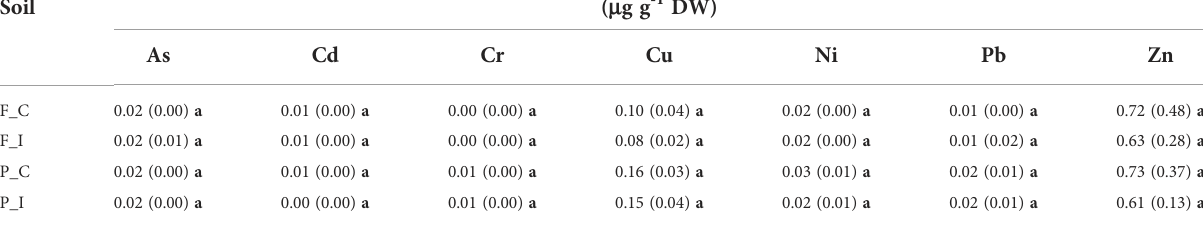
TABLE 1 CaCl 2 -extractable TE concentrations of topsoil samples (0-20 cm) from the two sites (mg kg -1 DW), Fresnes-sur-Escaut (F) and Pierrelaye (P) and two treatments (Control, C; Inoculated,